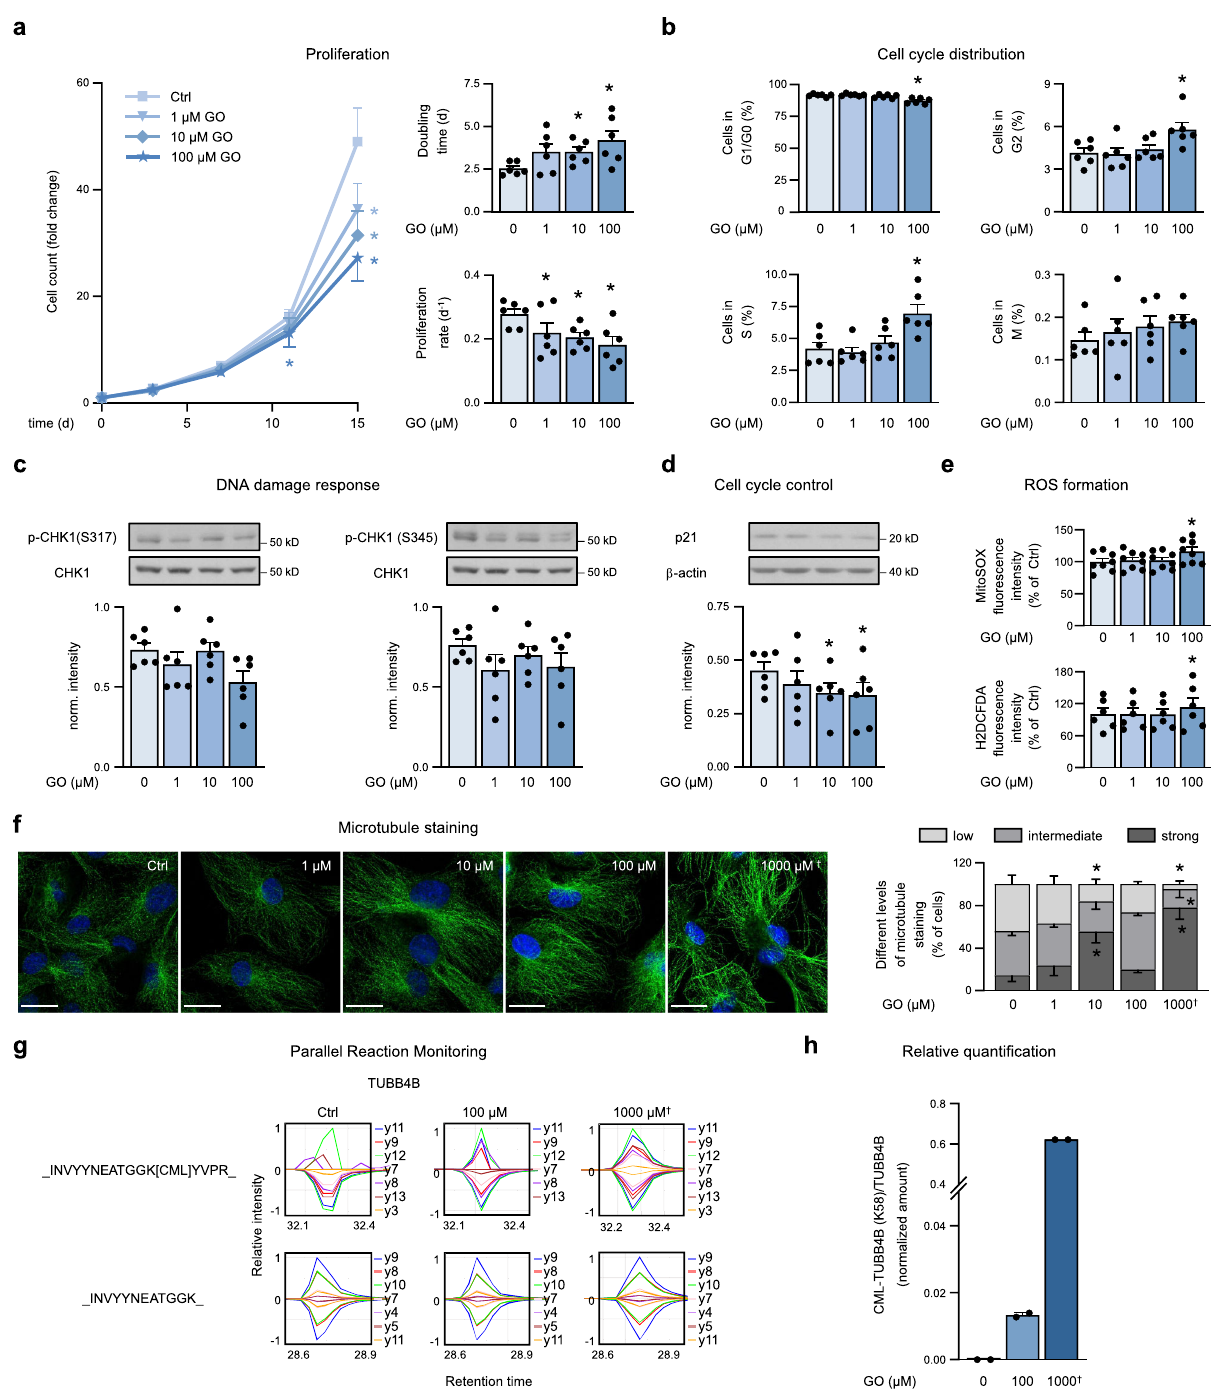
Fig. 7 Long-term treatment with low doses of glyoxal impairs proliferation and affects tubulin. a – h HUVEC were treated with 1 – 100 µ M GO for 14 d starting one day after seeding (day 1 – 15). a Left, cell numbers were counted over time. Right, doubling time and proliferation rates were calculated based on cell numbers of days 11 and 15. n = 8. b HUVEC were subjected to cell cycle analysis by fl ow cytometry applying a triple staining method (EdU, p-H3 (S10), DAPI). The proportion of cells in the respective cell cycle phases is shown. n = 6. c , d Cells were subjected to immunoblot analysis. n = 6. e Intracellular ROS (dichlorodihydro fl uorescein diacetate (H2DCFDA)) and mitochondrial ROS (MitoSOX) were measured by fl ow cytometry. n = 6 (H2DCFDA), n = 8 (MitoSOX). f Cells were stained using antibodies against α / β -tubulin and DAPI. Representative pictures (left) and the percentage of cells showing low, intermediate, or strong staining of microtubules per high-power fi eld (right) are shown. Ctrl: control. Scale bar = 20 µ m. n = 5. g Validation of CML- modi fi ed peptides by parallel reaction monitoring (PRM) using heavy spike-in peptides. h Relative quanti fi cation of _INVYYNEATGGK[CML]YVPR_ (from TUBB4B) in GO-treated HUVEC. Quanti fi cation was performed on elution samples after CMLpepIP. n = 2. f – h A treatment with 1000 µ M GO for 48 h was used as the positive control ( † ). a – f , h : Bar graphs show mean + SEM. Statistical signi fi cance was analyzed using one-way repeated measurement ANOVA corrected via Holm – Š idák method. * p < 0.05 vs. control. Source data are provided as a Source Data fi le. Speci fi c p values are listed in Supplementary Data 6. Related to Supplementary Fig. 8 and Supplementary Data